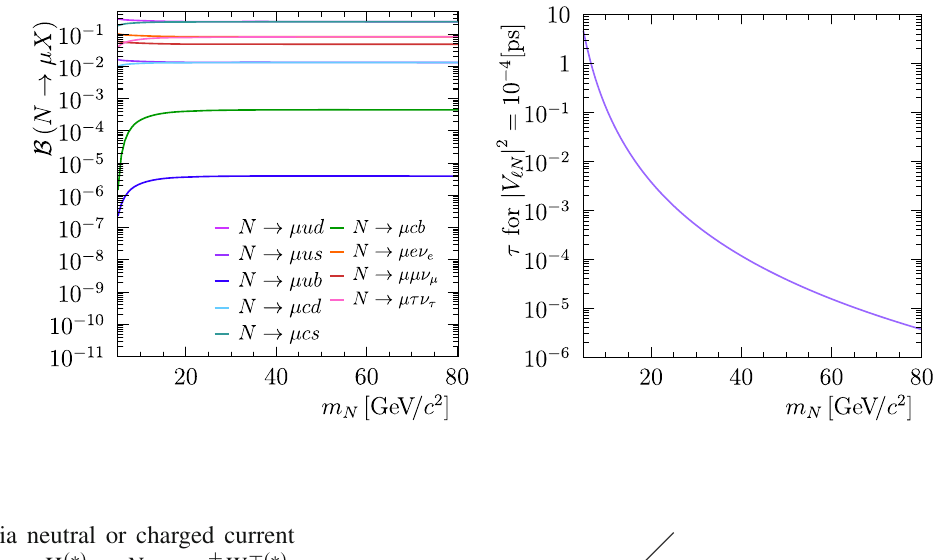
Fig. 1 Properties of a heavy neutrino as a function of its mass [21,22]: (left) the branching fractions to final states with a muon and (right) the lifetime, assuming a coupling of 10 − 4